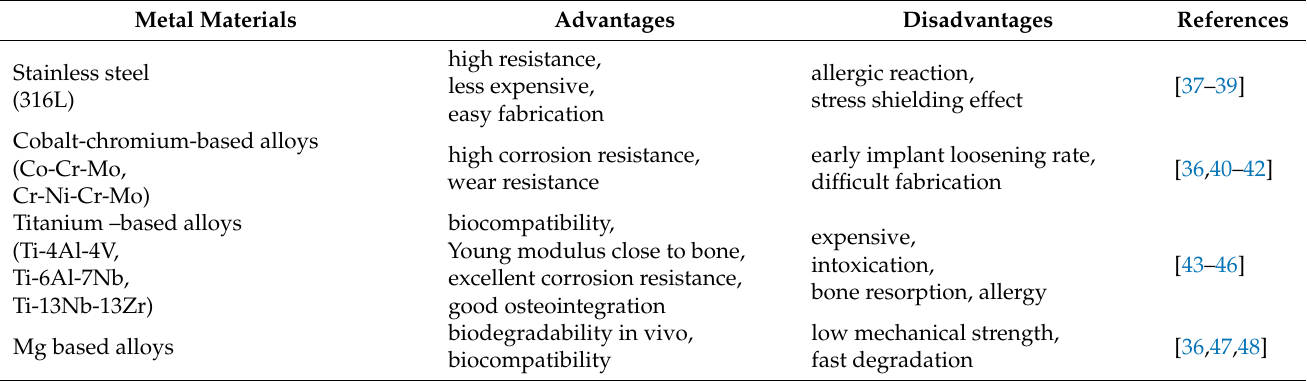
Table 1. Advantages and disadvantages of metal materials used in orthopedic